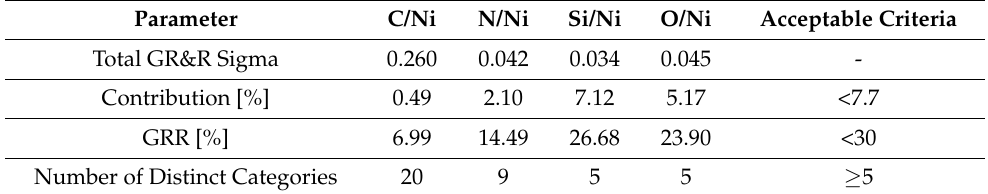
Table 1. Gauge Repeatability and Reproducibility (GR&R) results for C/Ni, N/Ni, Si/Ni and O/Ni